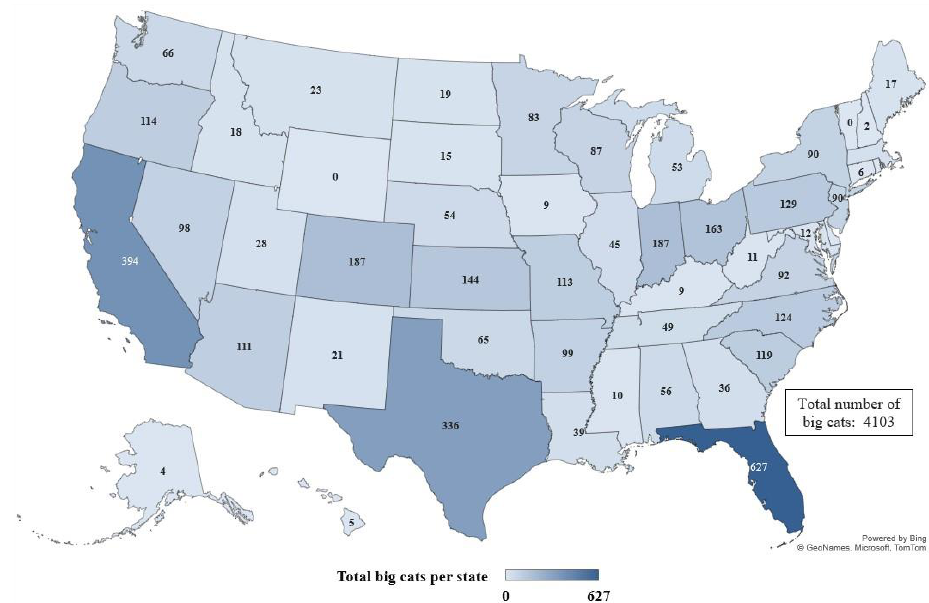
tively (Figure 5). Wyoming, Delaware, and Vermont were recorded as having none.